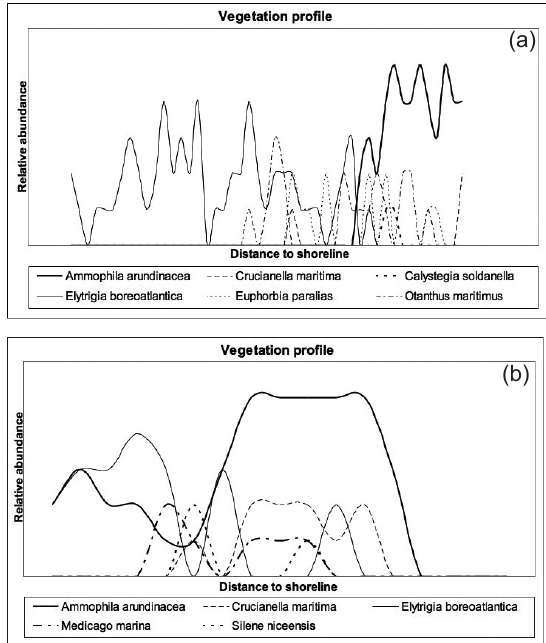
Figure 3. (a) typical vegetation profile of a (meta-) stable site (‘S1’) of the northern Portuguese coastline (Quiaios). Notice the clear floristic discrimination between Elytrigia -dominated vege- tation of embryonic foredunes (left) and Ammophila -dominated formations of foredune crests (right). Mean point species rich- ness along the profile is 1.51. (b) typical vegetation profile of a transgressive site (‘T’; Foz do Neiva site). Notice the continuum between Elytrigia -dominated vegetation of embryonic foredunes and Ammophila -dominated formations of foredunes, with Am- mophila arundinacea , Elytrigia boreoatlantica and other species occurring throughout the vegetation profile (indicating more homogeneous environmental conditions). Mean point species richness along the profile is 2.24.